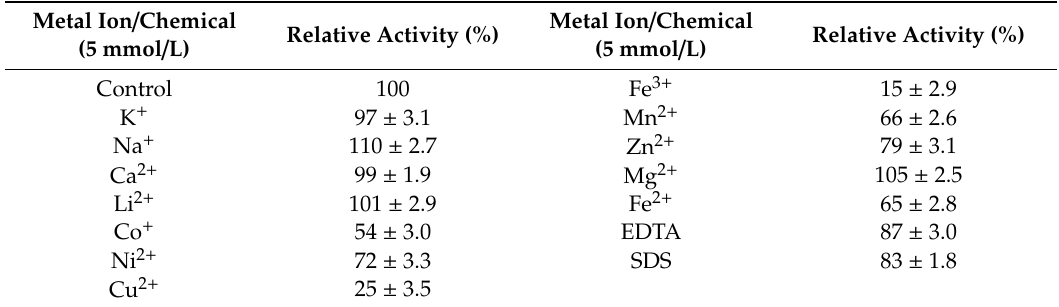
Table 2. E ff ects of metal ions and other chemicals on agarase activity of rAga-ms-R. Metal Ion / Chemical Metal Ion / Chemical Relative Activity (%) Relative Activity (%) (5 mmol / L) (5 mmol / L) Control 100 Fe 3 + 15 ± 2.9 97 ± 3.1 Mn 2 + 66 ± 2.6 Na + 110 ± 2.7 79 ± 3.1 99 ± 1.9 105 ± 2.5 54 ±